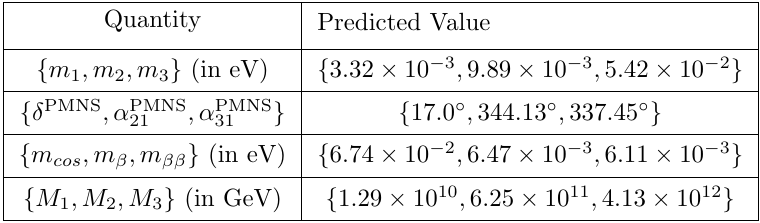
2 m m i , m (cid:12) = P U ei i is i i j j P U 2 m i is the e(cid:11)ective mass parameter ei i j j